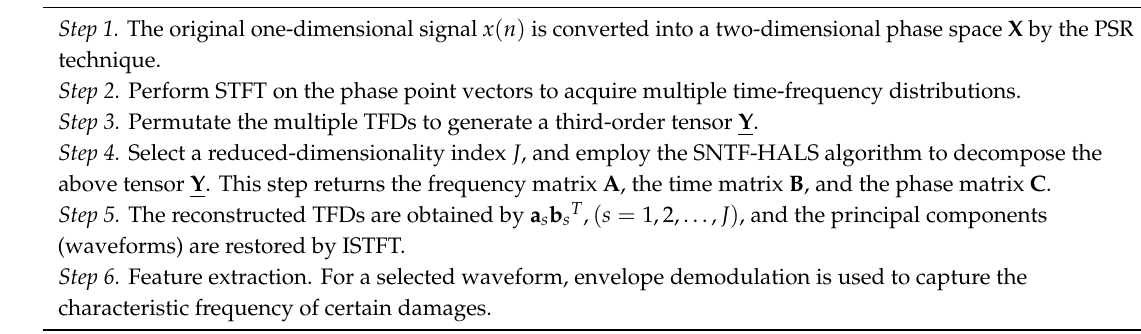
Algorithm 1: Feature Extraction Method for Vibration Signals Based on